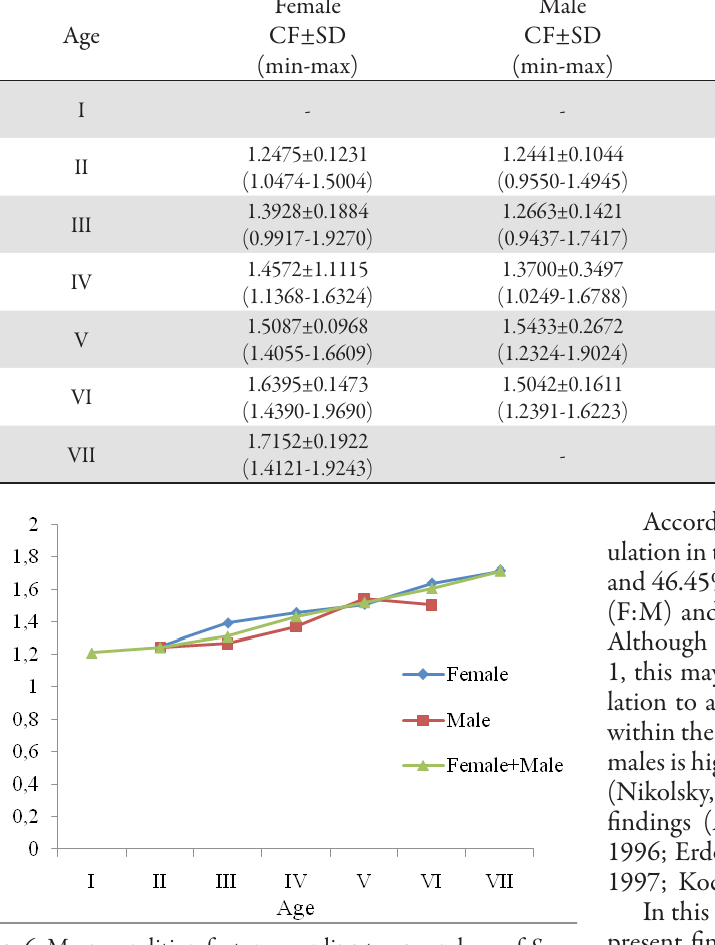
Fig. 6. Mean condition factor according to age and sex of S. ce-